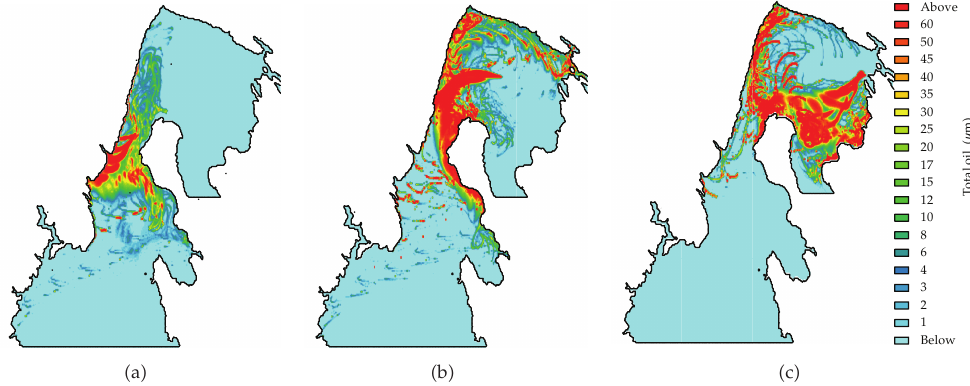
Figure 14: Fields of oil thickness with maximum simulated values for all numerical cells in the surface layer during the entire winter period 28/2/08–09/03/08 (cid:4)(cid:4) a (cid:5) oil spill released at the position 1; (cid:4) b (cid:5) at the position 2; (cid:4) c (cid:5) at the position 3 (cid:5)